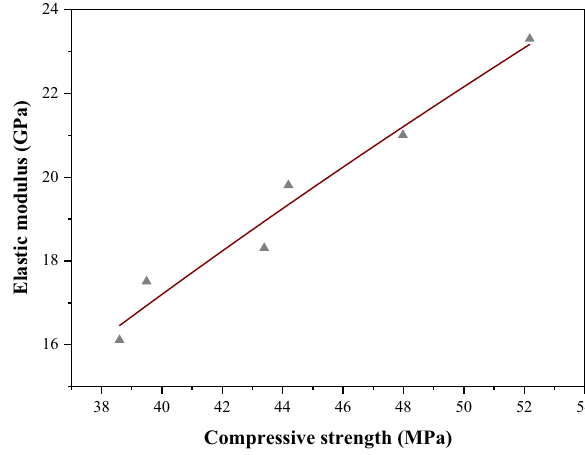
Figure 14: Elastic modulus versus cubic compressive strength.